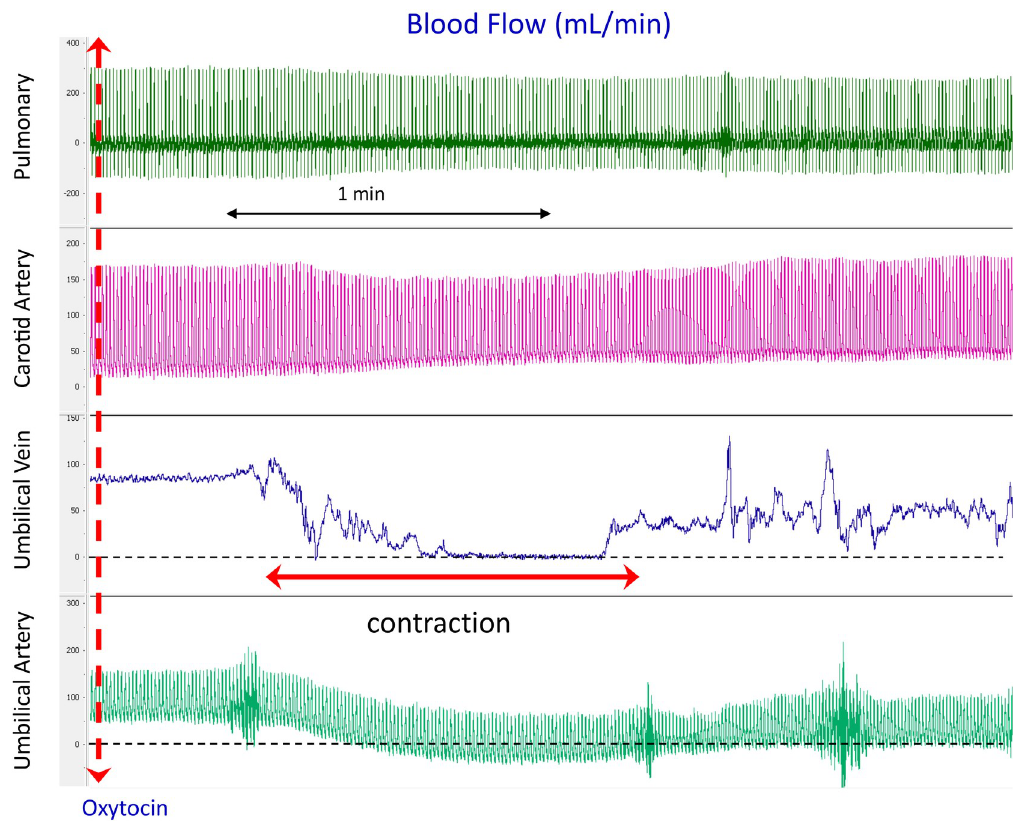
Fig 1. Physiological recordings of blood flows in the left pulmonary artery (PA), carotid artery, umbilical vein (UV) and umbilical artery (UA) before and immediately after oxytocin administration (iv) to the ewe in a newborn lamb prior to UCC and before ventilation onset. Note that during the contraction, UV flow decreases to 0, UA flow decreases and reverses during diastole (indicated by diastolic flows below zero) and CA flow